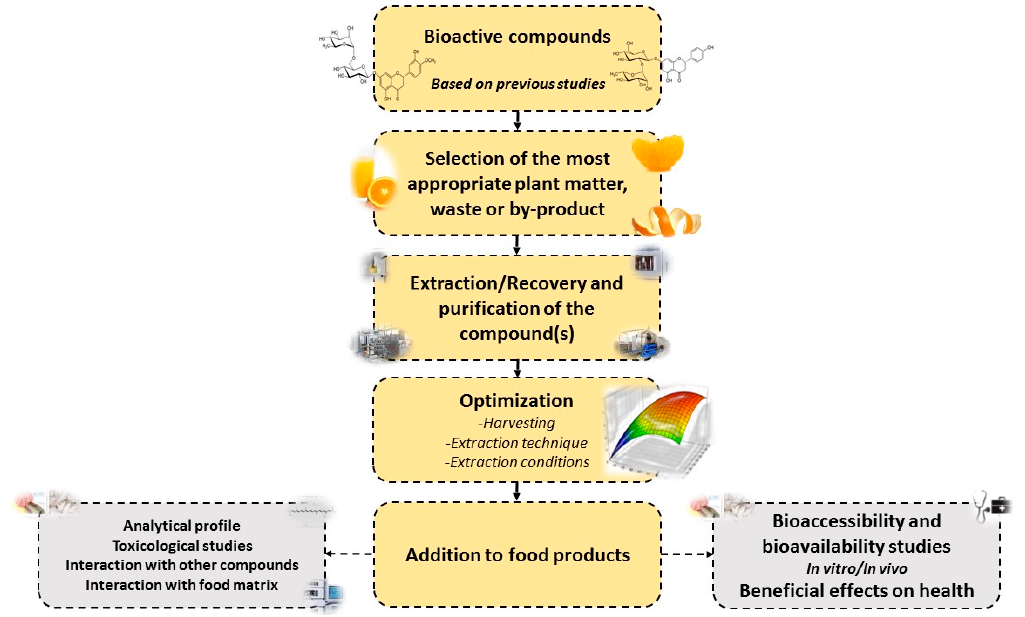
Figure 3. Set-up for the development and evaluation of a new functional bioactive compound- (extracts and/or isolated compounds) based product.